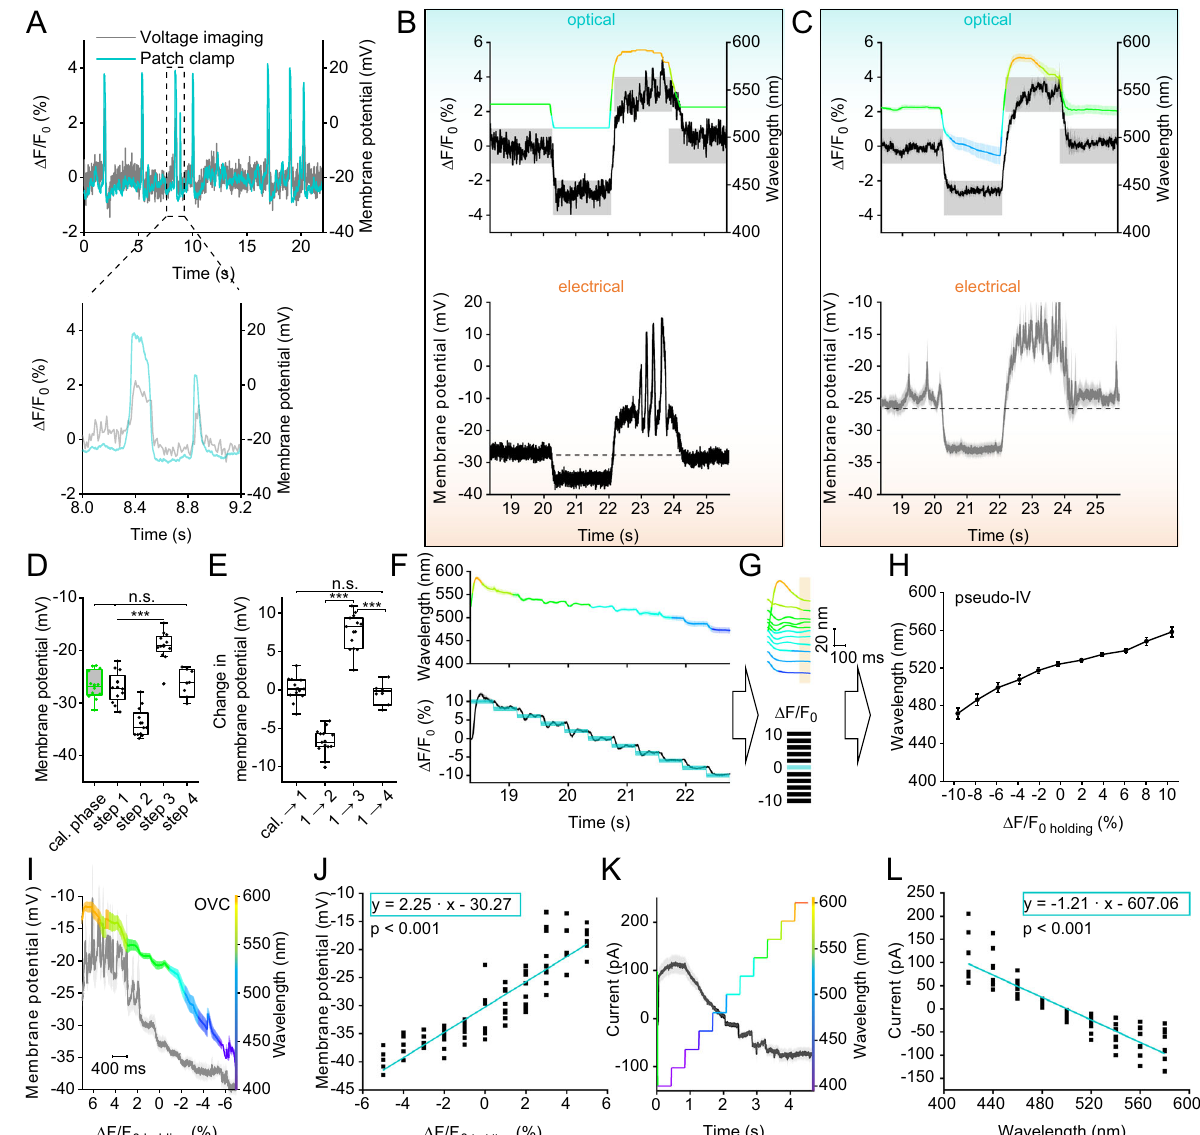
Fig. 2 | Bi-directional optical clamping and calibration of membrane voltage and currents in BWMs. A APs in simultaneous patch-clamp/ fl uorescence record- ingsduringOVCcalibration(637nmlaser+calibrationwavelength).Inset:close-up. B Simultaneous patch-clamp/ fl uorescence recording, OVC four-step protocol (0, − 3, 3, 0% Δ F / F 0 ). Upper: Fluorescence recording, wavelength adaptation and tol- erance ranges indicated. Lower: Corresponding patch-clamp voltage recording. C Overlay of mean (± S.E.M.) wavelength, fl uorescence (upper) and voltage